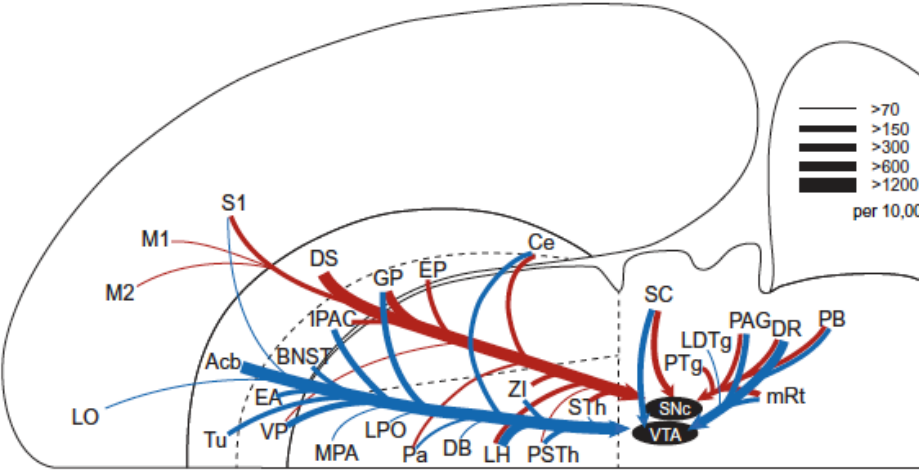
Figure 3. Horizontal-plane depiction of mono-synaptic inputs to VTA and SNc dopamine cell bodies (from [78]).